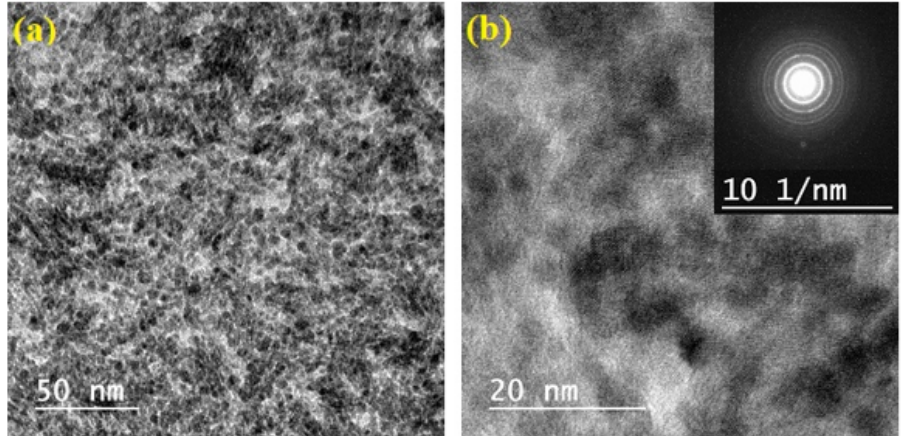
Figure 1. ( a ) TEM and ( b ) HRTEM images of TiO 2 nanoparticles; Inset: selected area electron diffraction (SAED) images of TiO 2 nanoparticles.